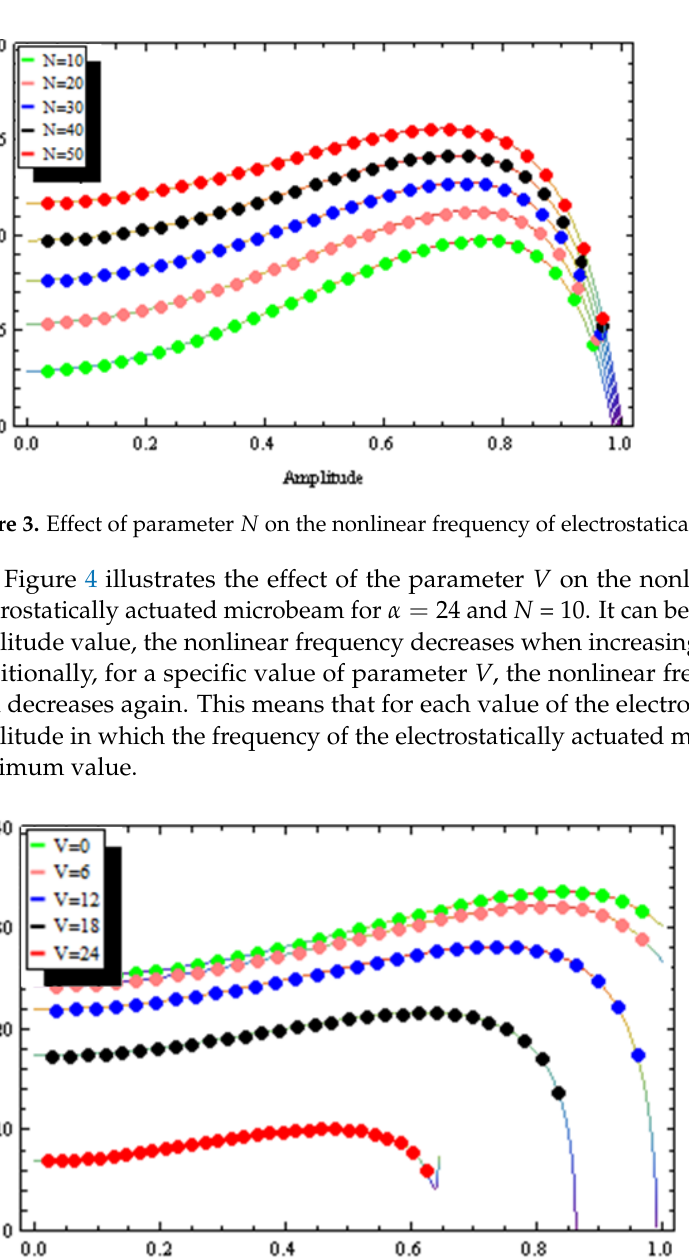
Figure 2. The comparison between analytical approximate solutions using the GRHBM (dashed line) and numerical solution (solid line). ( a ) A = 0.3, V = 0, N = 10, a = 24. ( c ) A = 0.6, V = 10, N = 10, a N = 10, = 24. ( f ) A = 1, V = 0, N = 10, a 20, N = 10, = 24.